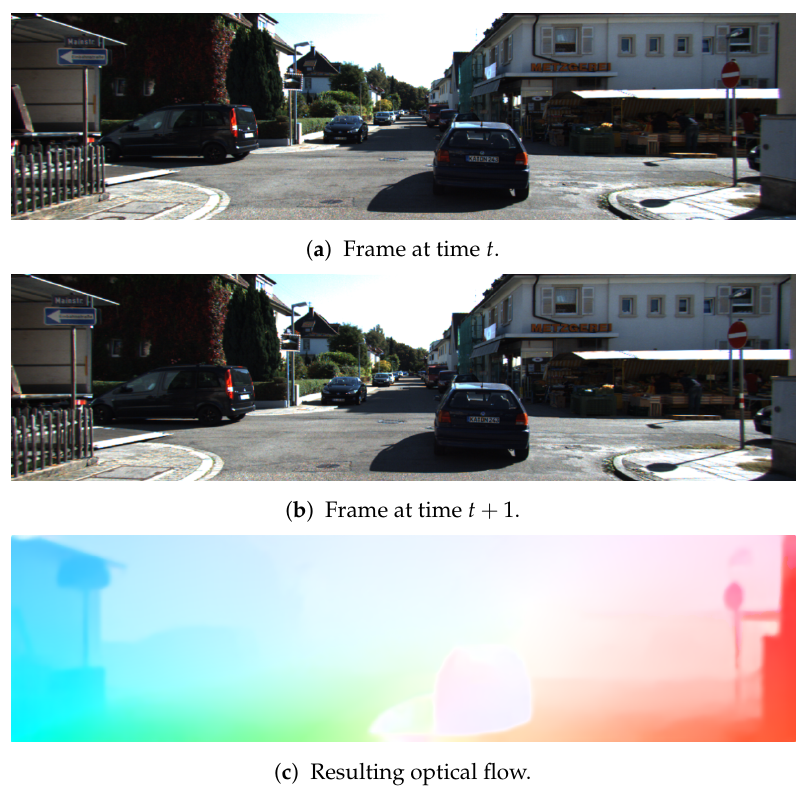
( c ) Resulting optical flow. Figure 3. Example frames from the KITTI dataset [40] and resulting optical flow using Lite- FlowNet